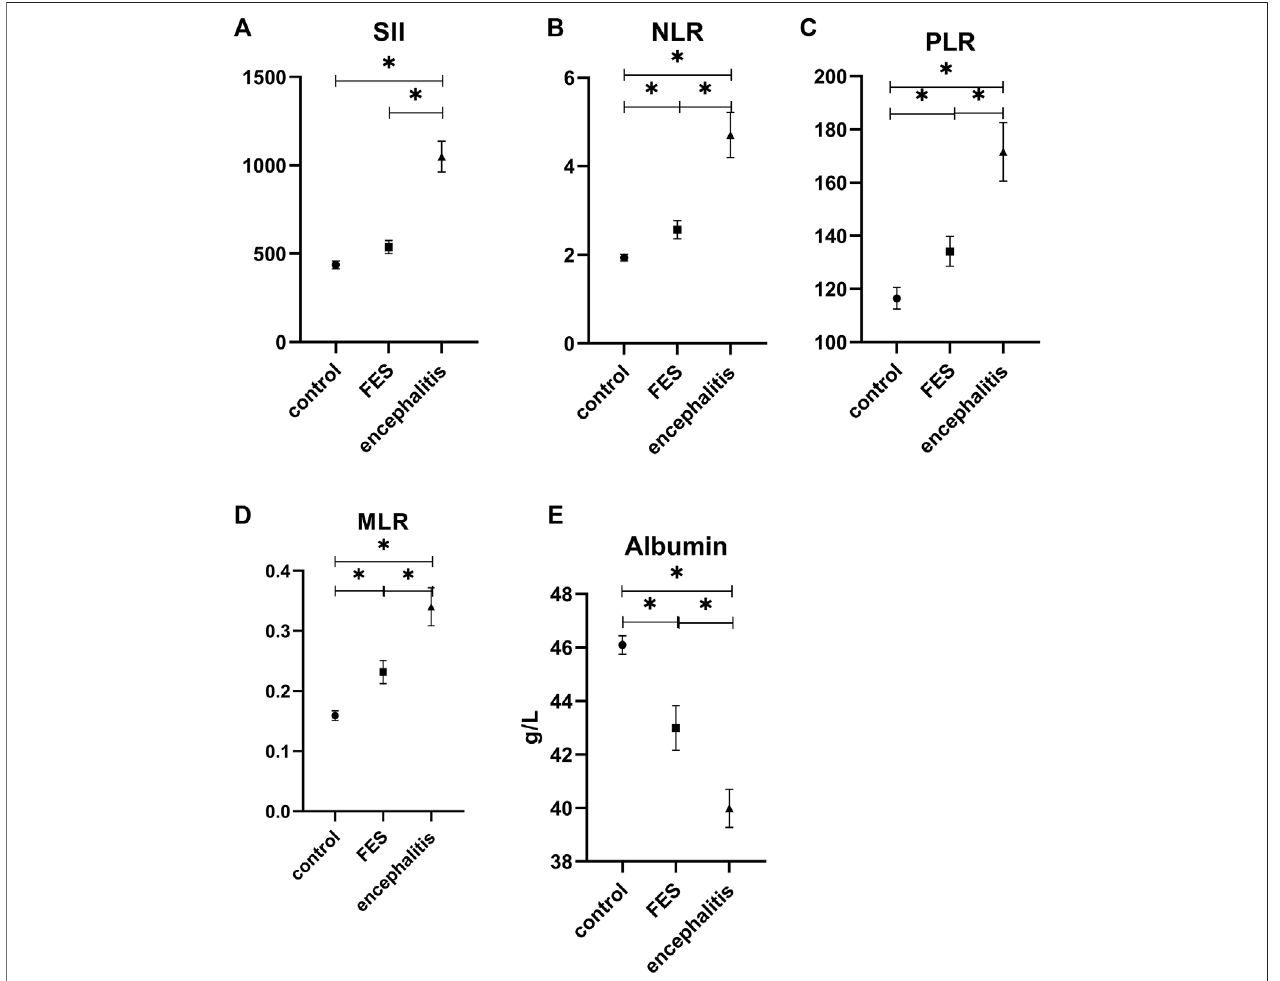
FIGURE 2 | Comparison of monocytes counts, SII, NLR, PLR, MLR, and serum albumin level in anti-NMDAR encephalitis, FES, and healthy control. FES, fi rst- episode schizophrenia; encephalitis, anti-NMDAR encephalitis; SII, immune-in fl ammation index; NLR, Neutrophil Lymphocyte Ratio; PLR, Platelet Lymphocyte Ratio; MLR, Monocyte Lymphocyte Ratio. * p < 0.05. All the above parameters were using Games-Howell tests.